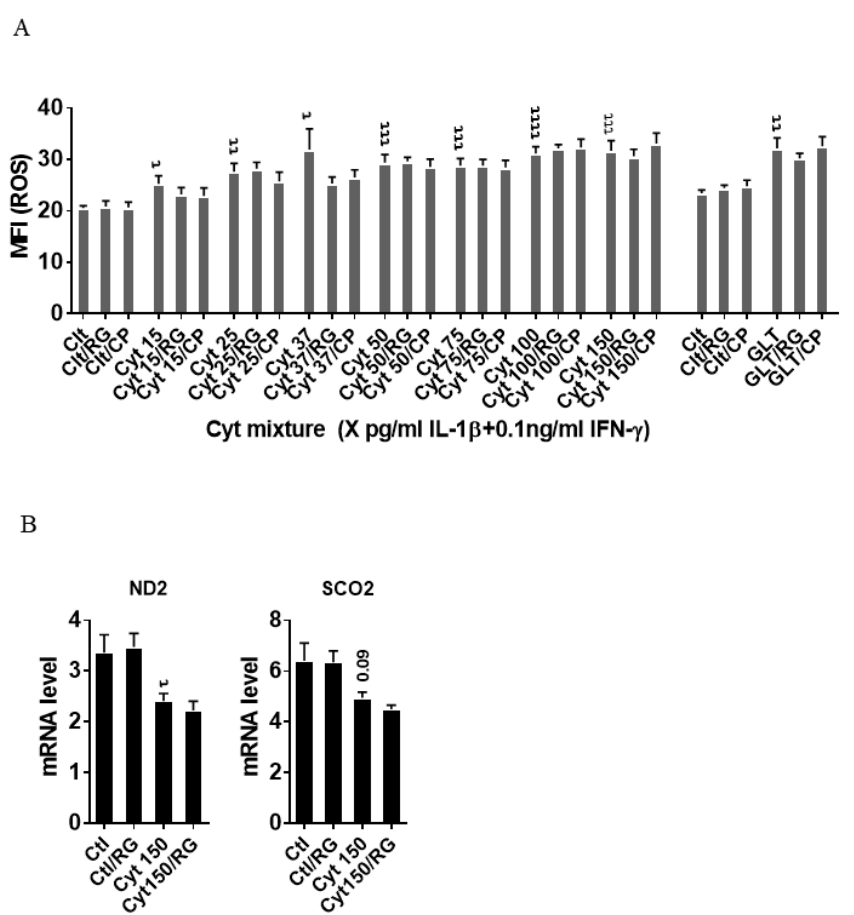
Figure 3. Rotigaptide does not reduce inflammatory or glucolipotoxicity-induced intracellular ROS in INS-1 cells. INS-1 cells were pre-incubated with or without 100 nM Rotigaptide (RG) or control peptide ZP119 (CP) for one hour in the presence or absence of cytokine mixture (IL-1 β in the concentrations indicated + 0.1 ng / mL IFN γ ; Cyt) or glucolipotoxicity (0.5 µ M Palmitate + 25 mM glucose; GLT) for 18 h. ( A ) Cellular ROS level was determined using DCF assay and presented as MFI. ( B ) The mRNA level of NADH-dehydrogenase subunit 2 ( ND2 ) and Cytochrome C Oxidase II ( Sco2 ) genes was determined using specific primers with qPCR . The expression of the genes normalized to HPRT1 was calculated by − ∆ Ct. Data are the means ± SEM of N = 6 (for A) / N = 4 (for B) independent experiments. τ ≤ 0.05, ττ ≤ 0.01, τττ ≤ 0.001, ττττ ≤ 0.0001. The symbols τ indicate the Bonferroni-corrected paired t -test values of cytokine (Cyt) exposure versus control (CTL) and Cyt exposure versus exposure to Cyt and RG, respectively. ROS: reactive oxygen species, MFI: mean fluorescent intensity, DCF: